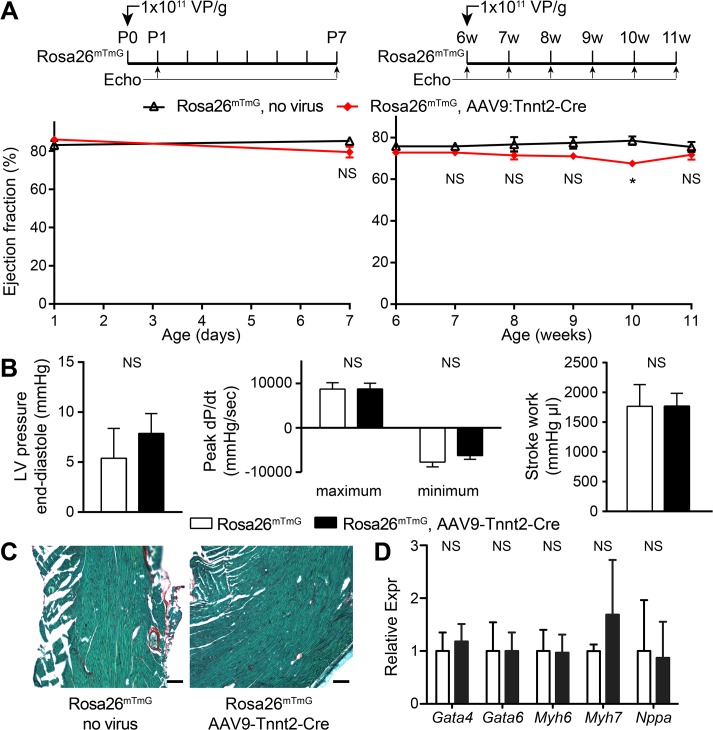
AAV9:Tnnt2-Cre had minimal effect on Rosa26mTmG heart functional parameters.
(A). Neonatal (left) and adult (right) treatment timelines and echocardiographic evaluation of heart function. n = 8 per group. *, P<0.05. (B). Closed chest invasive hemodynamics assessment of effect of AAV9:Tnnt2-Cre on cardiac function. n = 5 per group. (C). Fast green-picrosirius red staining of heart sections. Red staining indicates fibrosis. Bar = 30 μm. (D). qRTPCR assessment of relative gene expression. n = 3. NS, not significant.